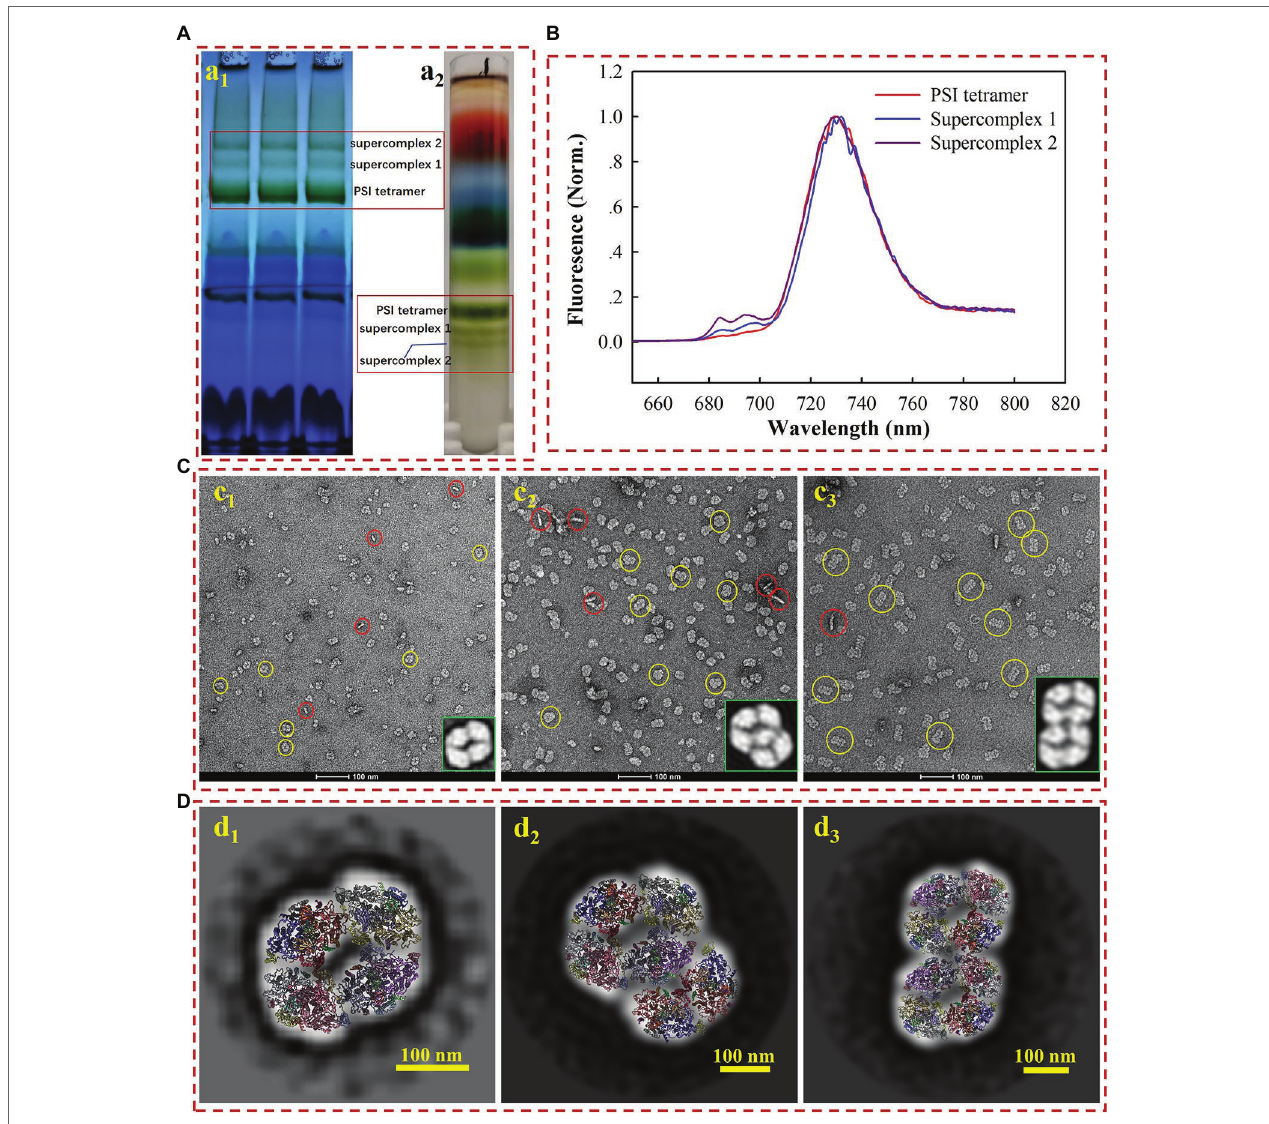
FIGURE 1 | Biochemical (A) and biophysical (B–D) characterization of the PSI tetramer, supercomplex 1, and supercomplex 2. (a 1 ) Membrane crude extracts were loaded on BN-PAGE at a total amount of 9–12 μ g chlorophyll a for each lane; (a 2 ) membrane crude extracts were loaded on sucrose gradient ultracentrifugation for the separation of PSI tetramer and supercomplexes. (B) Low temperature (77 k) fluorescence emission detection of PSI tetramer (red line), supercomplex 1 (blue line), and supercomplex 2 (purple line). (C) Negative staining electron microscopy image of PSI tetramer (c 1 ) supercomplex 1 (c 2 ) and supercomplex 2 (c 3 ) . The yellow and red circles indicate the top and side views, respectively. The enlarged image in the right corner shows the 2D averages of the most contributed particles. (D) The average 2D model-fitted maps of the PSI tetramer (d 1 ) supercomplex 1 (d 2 ) and supercomplex 2 (d 3 )